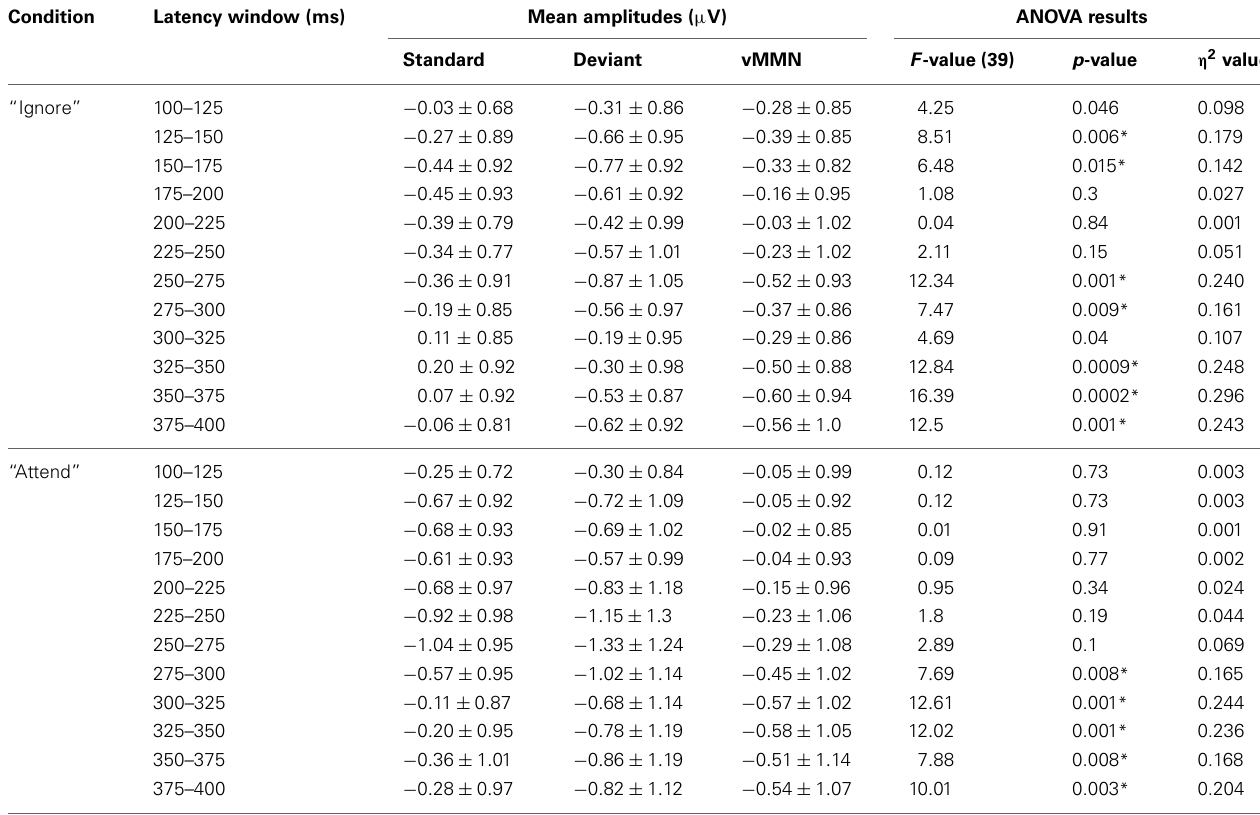
Table 1 | Mean amplitudes of standard, deviant and difference (vMMN) waveforms and repeated measures ANOVA results showing the comparison of standard and deviant mean amplitude for each latency window and condition in Occipital area for 40 subjects.